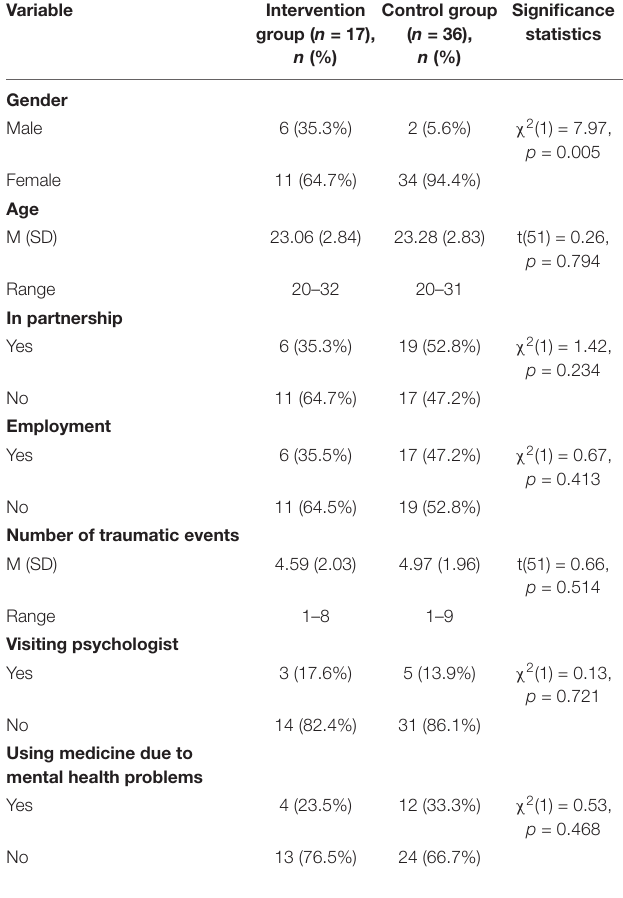
TABLE 1 | Characteristics of the study participants ( n = 53) at pre-test. Variable Intervention group ( n = 17), n